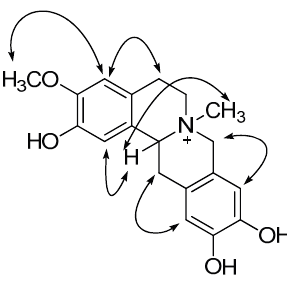
Figure 3. Key NOE of compound 1